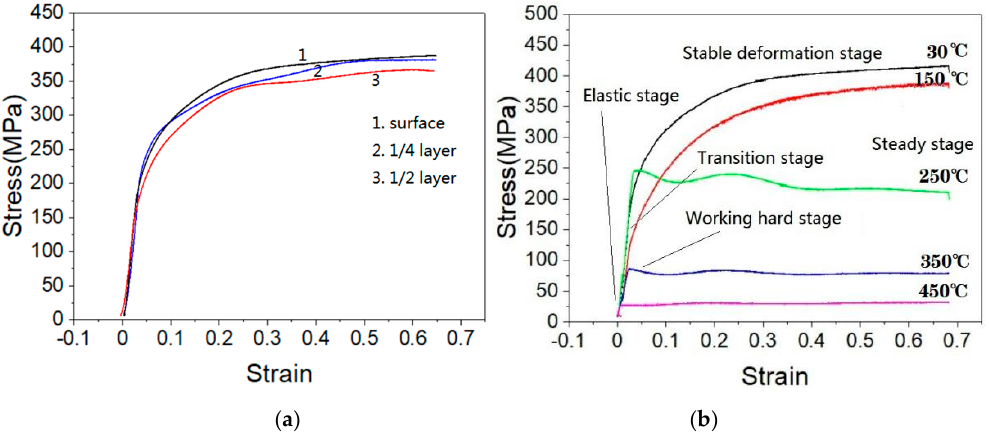
Figure 8. True stress-strain curves. ( a ) Compression specimens of different layers at room temperature; ( b ) compression specimens of surface layer at different temperatures. ( b ) compression specimens of surface layer at di ff erent temperatures.